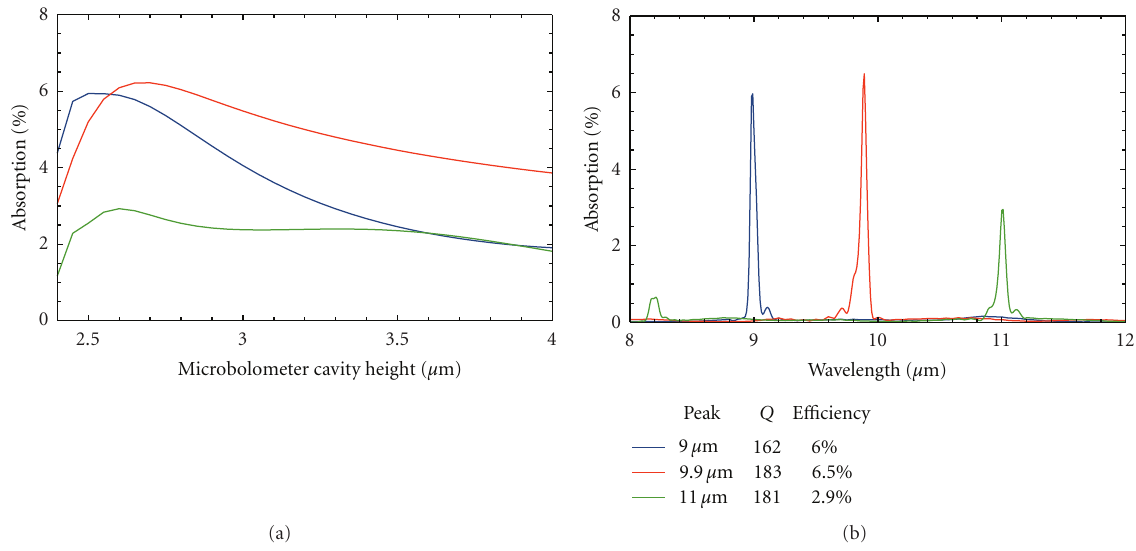
Figure 6: (a) Relative power absorbed in the microbolometer as a function of h MC for the 9, 9.9, and 11 μ m filters. (b) Spectral performance for a microbolometer cavity height of 2.6 μ m. Note that the legend is used for both (a) and (b).